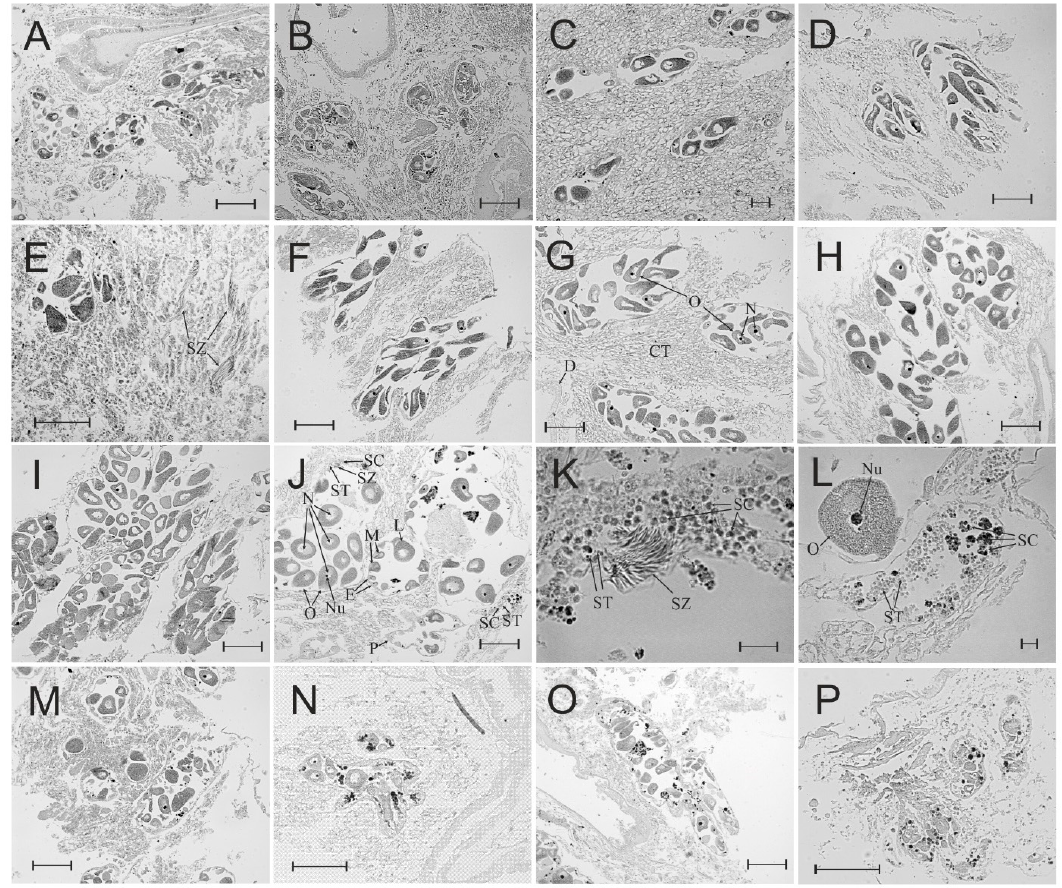
Figure 5. The gonads of hermaphroditic specimens of Corbicula form R at different stages of their reproductive cycle in